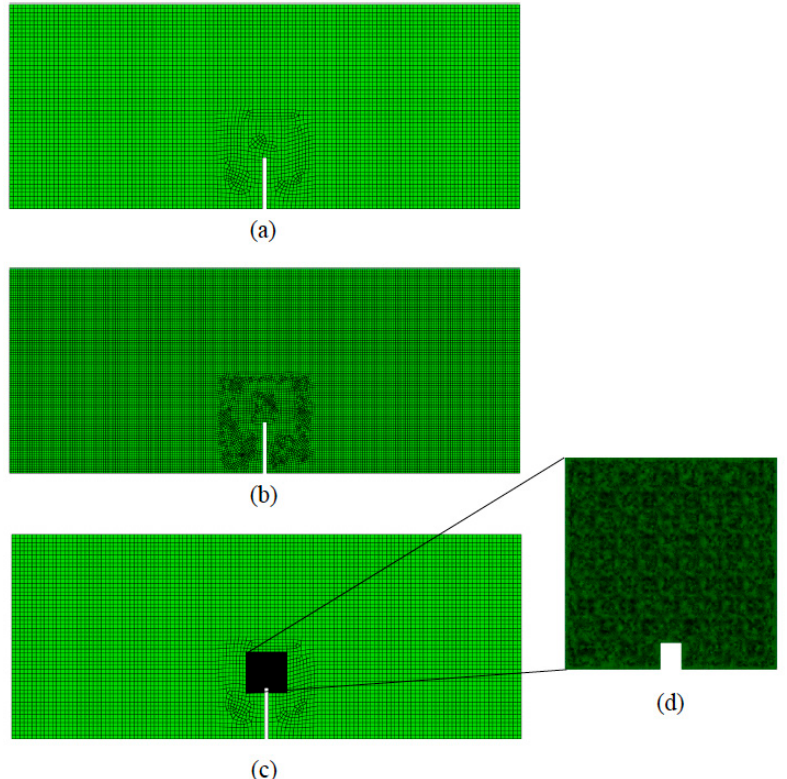
Figure 22. Domain decomposition should not be mistaken with mesh refinement. Figure ( a , b ) show a macroscale model with coarse and fine meshes, while a multiscale domain with macroscale ( c ) and microscale ( d ) subdomains may have different mesh